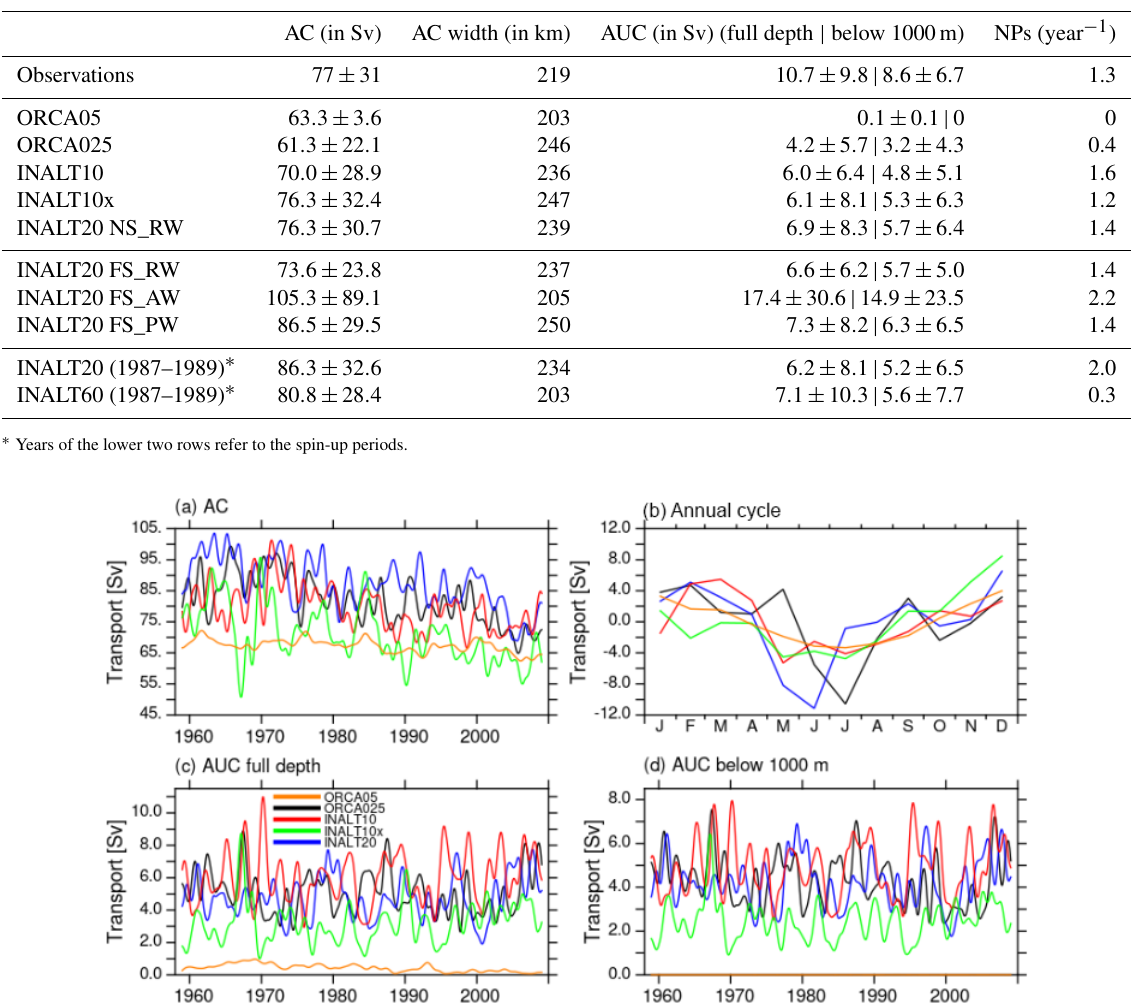
Table 10. Mean (2005–2009) transport (in Sv) and standard deviations based on 5d averages at the ACT section, current widths (in km) and number of Natal Pulses (NPs) per year in the corresponding period. Observational numbers are based on Beal and Elipot (2016). The Agulhas Undercurrent transport is given as the full depth-integrated northeastward transport from the coast to 200km off-shore and for the water column below 1000m.